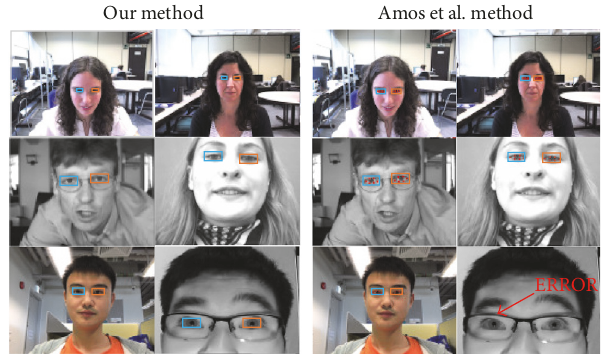
Figure 8: Some results of eye location and classification. The blue box represents the right eye while the orange box represents the left eye.